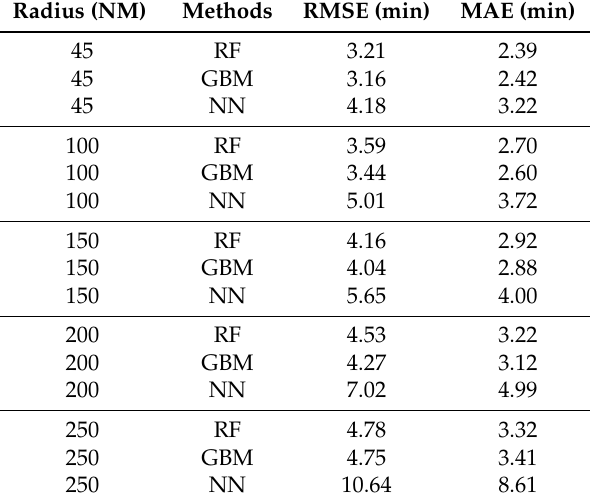
Table 2. Accuracy evaluation results (RMSE and MAE) of three machine learning methods in order to predict the aircraft landing time. GBM, Gradient Boosting Machine.